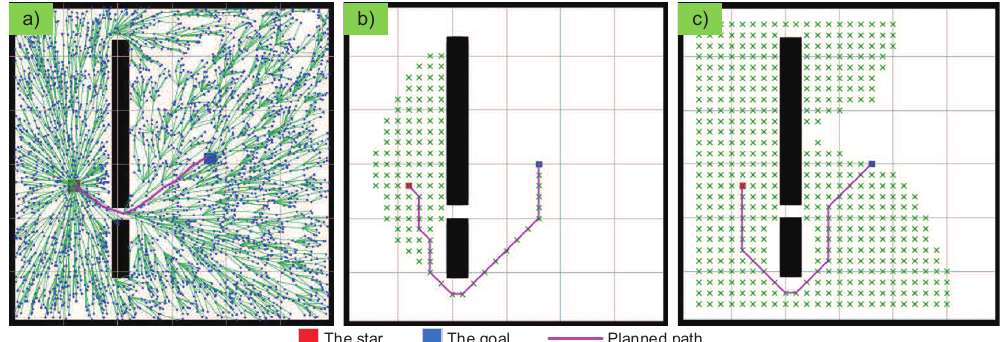
Figure 2. A simulation comparison of the ( a ) optimal rapidly-exploring random tree (RRT*), ( b ) A*, and ( c ) D* planners in the same scenario. A* and D* fail to find the shortest path because of the optimal path within a narrow portion, however the RRT* planner successfully finds the suboptimal path through the narrow portion.